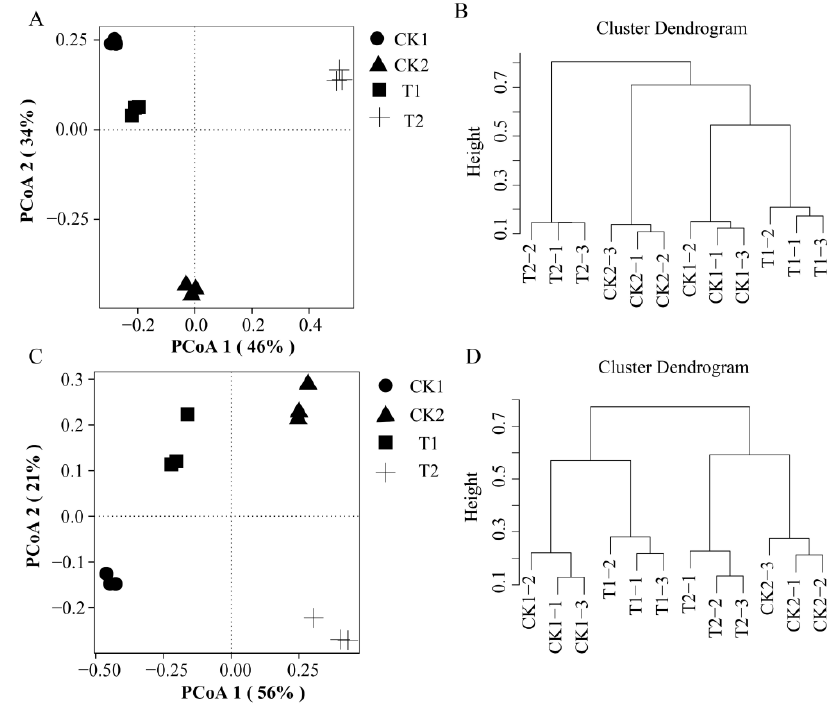
Figure 4. Principal component analysis ( A , C ) and cluster analysis ( B , D ) of T-RFLP patterns of bacteria ( A , B ) and fungi ( C , D ) in the soil relative to treatment based on the Bray–Curtis method. CK1: replant control, CK2: methyl bromide fumigation, T1: blank carrier treatment, T2: QSB-6 bacterial fertilizer treatment. Each treatment includes three repetitions. Table 4. Effects of different treatments on microbial diversity in the rhizosphere of young apple trees in three places.